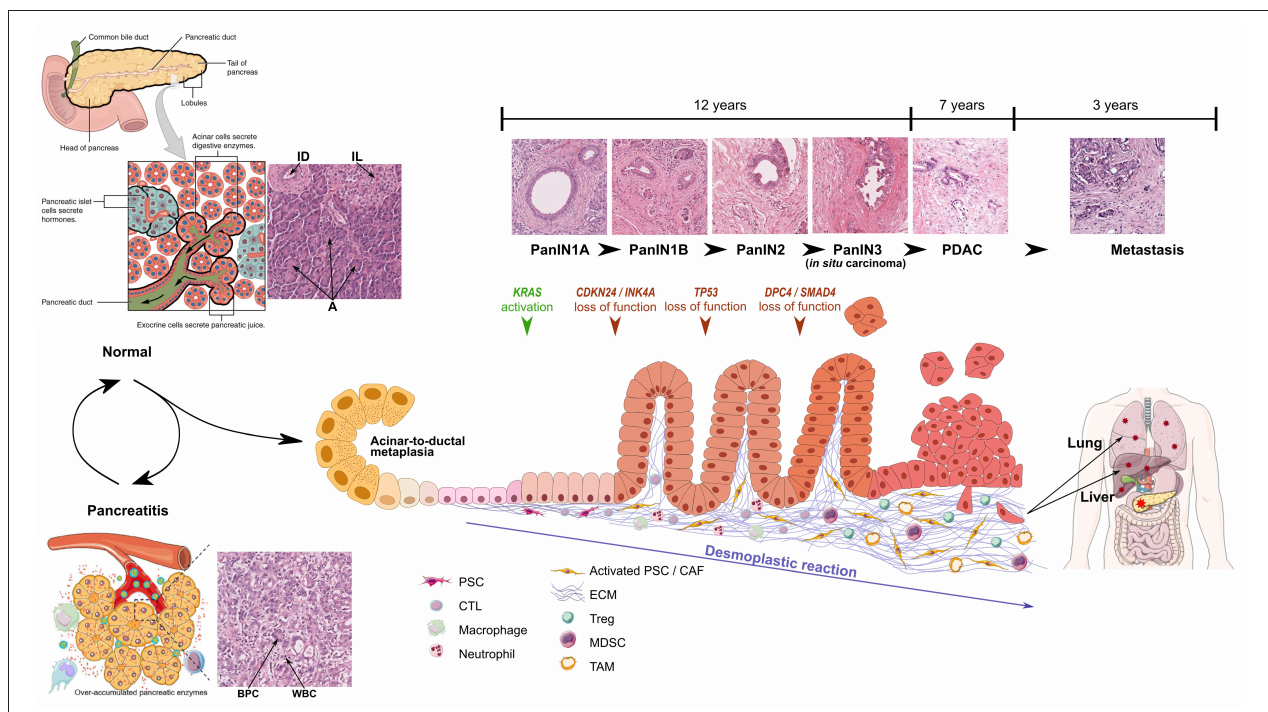
FIGURE 1 | Schematic representations and optical microscopic images of normal pancreas, pancreatitis, and progression from PanIN1 to invasive PDAC. Particular focus is made on development of desmoplastic stroma. Pancreatitis schematic representation from Yao et al. (2), PanIN progression inspired from Morris et al. (3). ID, Interlobular Duct; IL, Islet of Langerhans; A, Acini; BPC, Benign Pancreatic Cells; WBC, White Blood Cells. Healthy pancreas scheme has been obtained from OpenStax College - Anatomy & Physiology.